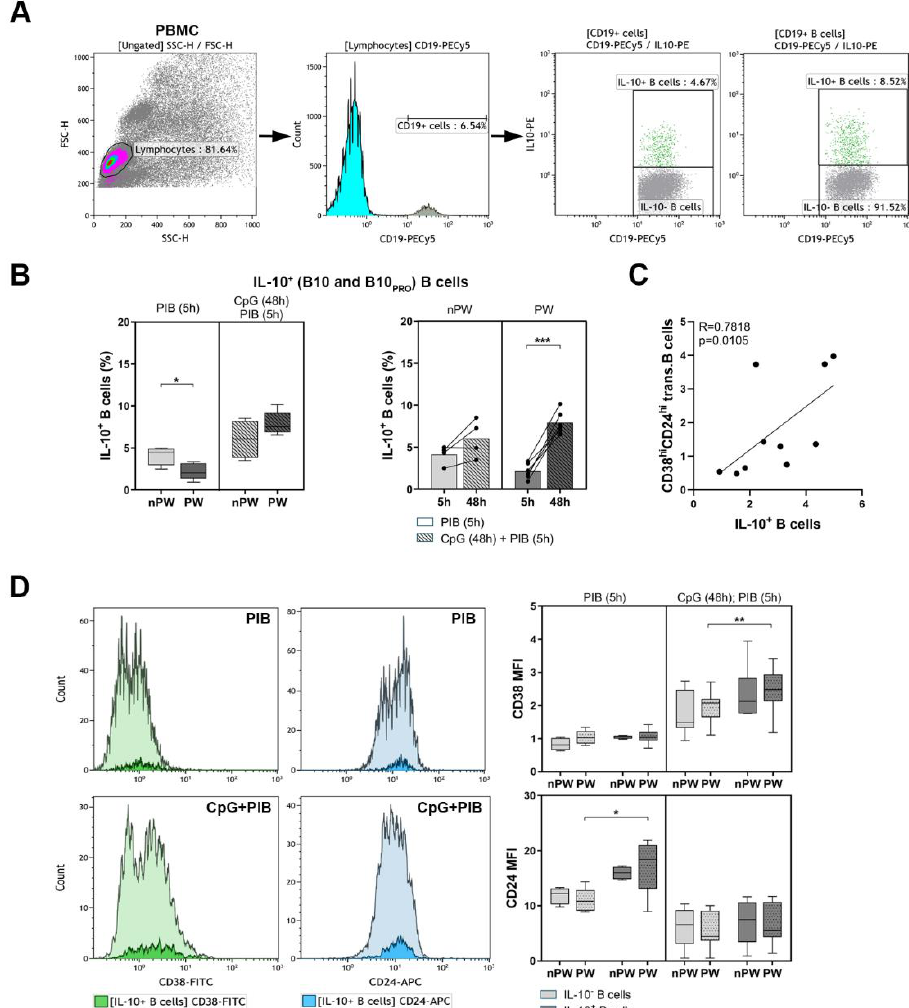
Figure 4. PBMCs were isolated from 6 healthy pregnant women (PW) and 4 healthy non-pregnant women (nPW), then they were stimulated with PMA/ionomycin/brefeldin-A (PIB) for 5 h and CpG-ODN for 48 h followed by restimulation with PIB for the last 5 h. ( A ) Representative dot plots and the histogram show the gating strategy of IL-10-producing B cells. ( B ) The percentages of IL-10 + B cells (B10 and B10 PRO ) after the stimulation with PIB and CpG-ODN + PIB. ( C ) Correlation analysis between the percentages of transitional B cells and IL-10-producing B cells. ( D ) The expression of CD38 and CD24 median fluorescence intensity (MFI) markers within IL-10 + and IL-10 − B cell sub- populations after stimulation with PIB and CpG-ODN + PIB. Box plots represent the interquartile range (IQR) with a line in the middle as the median value. Dots indicate individual subjects. Statis- tically significant differences are indicated by * p < 0.05; ** p < 0.01; *** p < 0.001. 4. Discussion Our findings indicated that the percentages of peripheral blood un-switched memory and transitional B cells significantly decreased in the third trimester of pregnancy. More- over, the proportions of both CD5 + CD1d + Breg and IL-10-producing B10 cells also de- creased, and these alterations may be crucial contributors to the physiological changes in the maternal immune status in the third trimester. Prior studies have revealed that circulating B cells are reduced during pregnancy and the distribution of B cell subsets undergoes changes in healthy pregnant women. The de- crease in peripheral blood B cells is most pronounced in the third trimester of pregnancy,